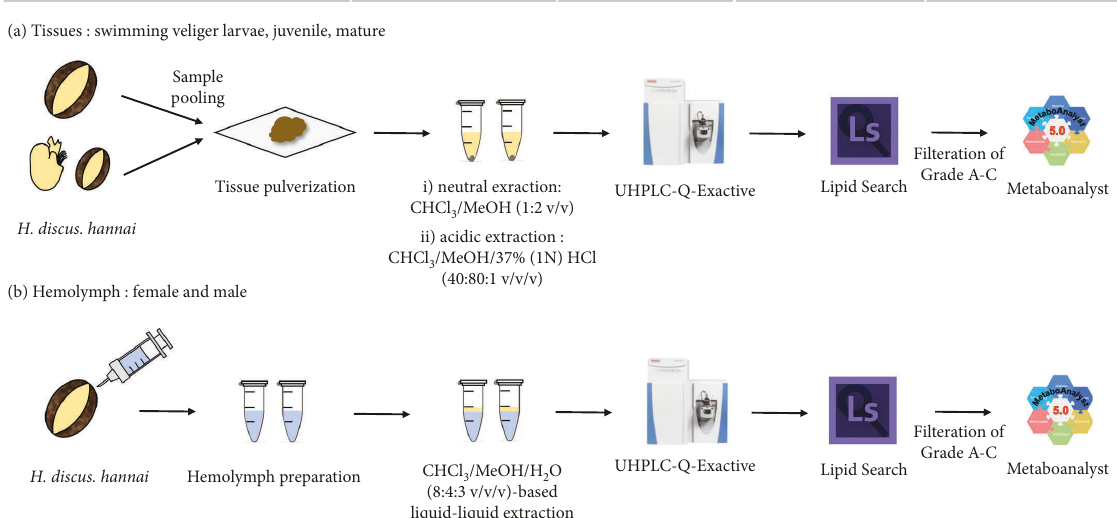
Figure 1: Workflow of the profile profiling of (a) abalone ( Haliotis discus hannai ) tissues at different development stages (swimming veliger larvae, juveniles, and mature adults) and (b) the hemolymph of female and male